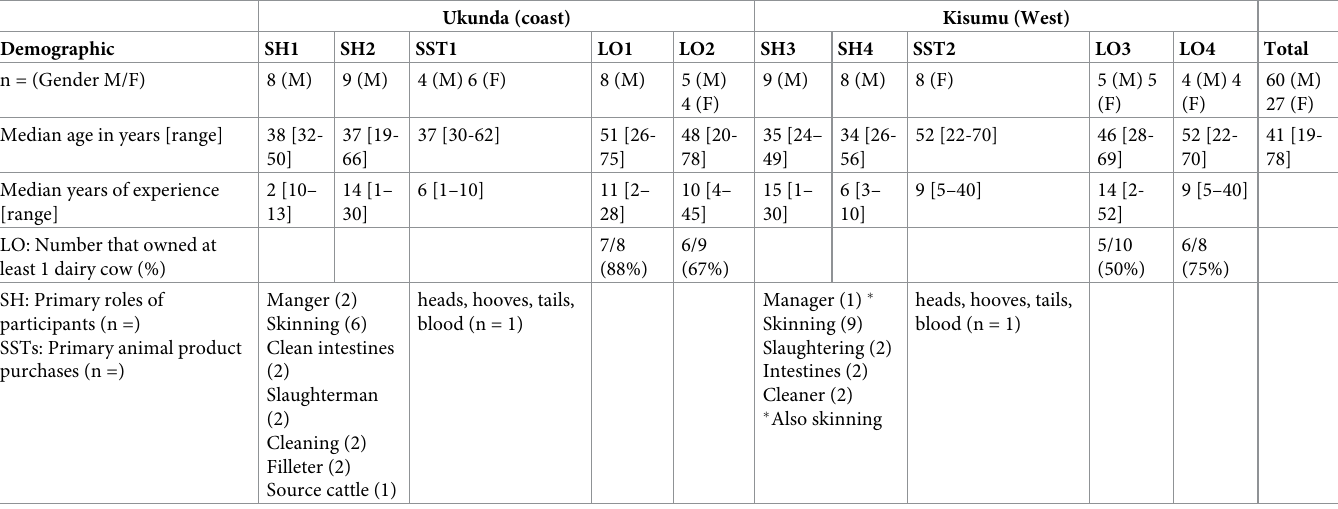
Table 1. Focus group discussion participant demographics.